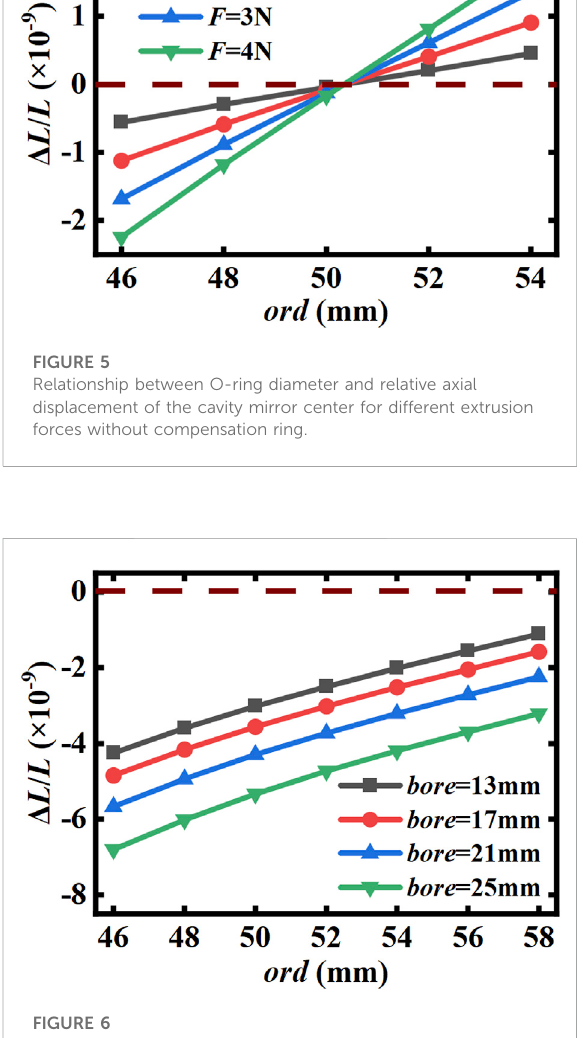
Relationship between the O-ring size and the relative axial displacementofthemirrorcenterinthe “ re-entrant ” structurewith different bore-aperture.